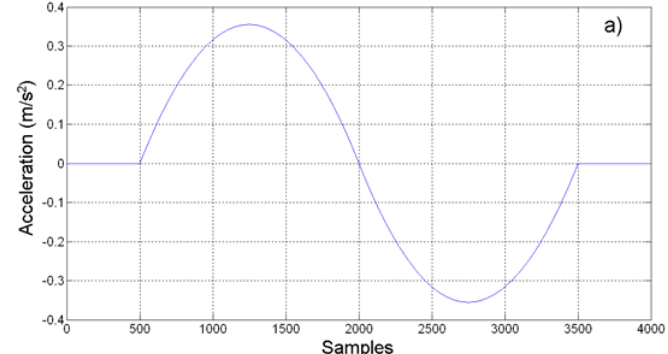
Figure 13. Profiles (a) Theoretical biquadratic acceleration profile. (b) Measured acceleration. (c) Theoretical jerk profile. (d) Jerk estimation at Nyquist sampling rate by finite